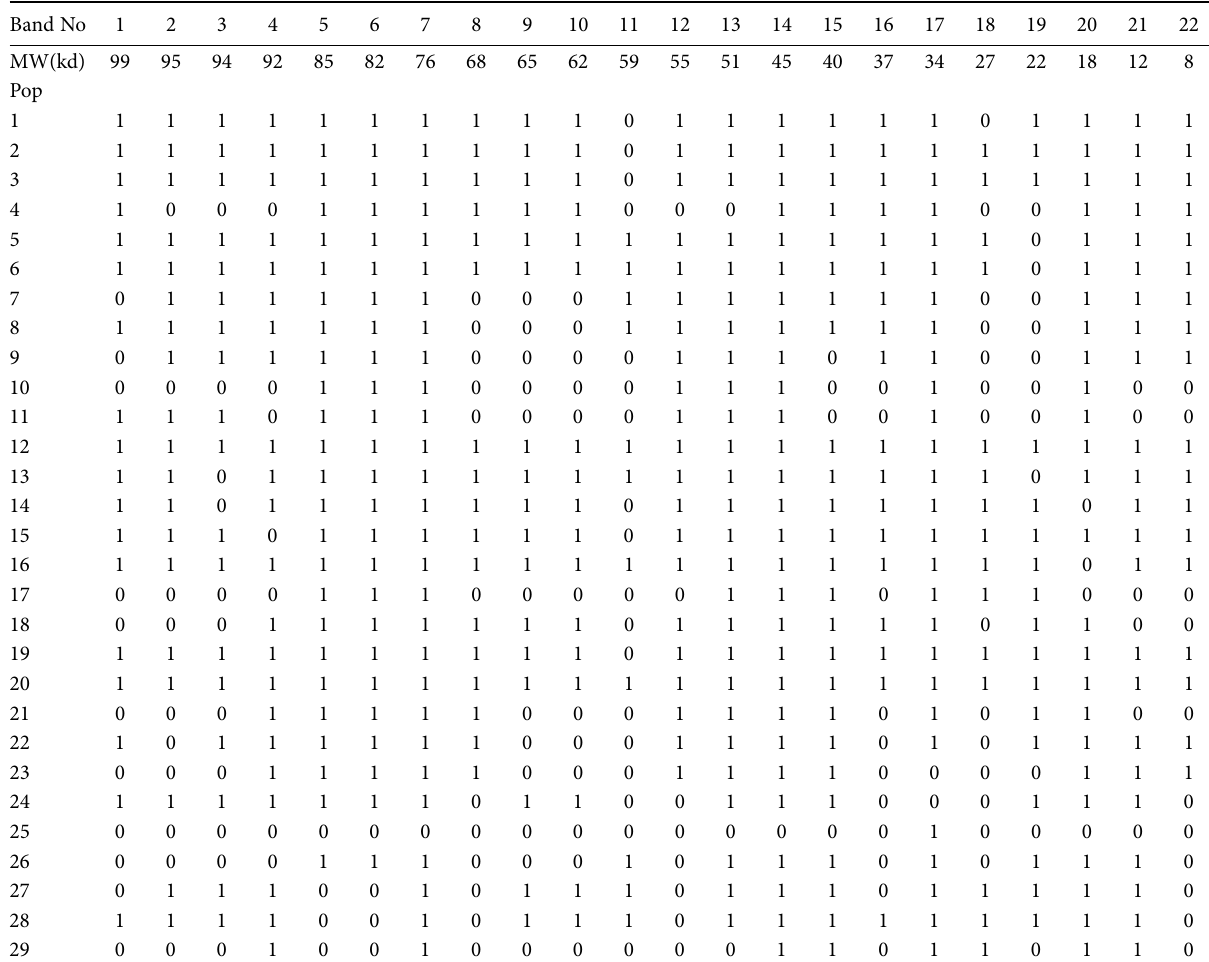
Table 2. Band number and molecular weight for each studied population of Hypericum . (1- band is present in the seed sample, 0- band is absent in the seed